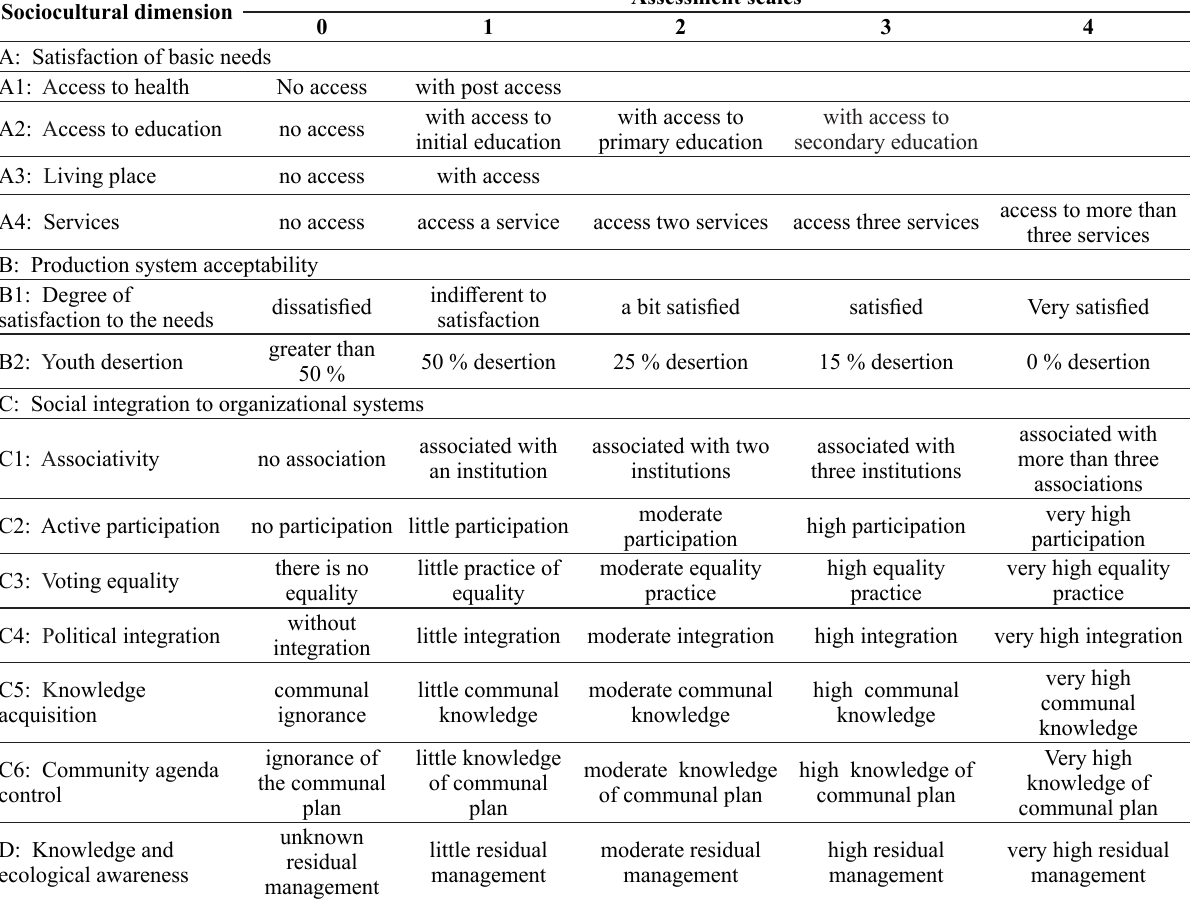
Table 3: Subindicadores, variables y escalas de valorización para evaluar la